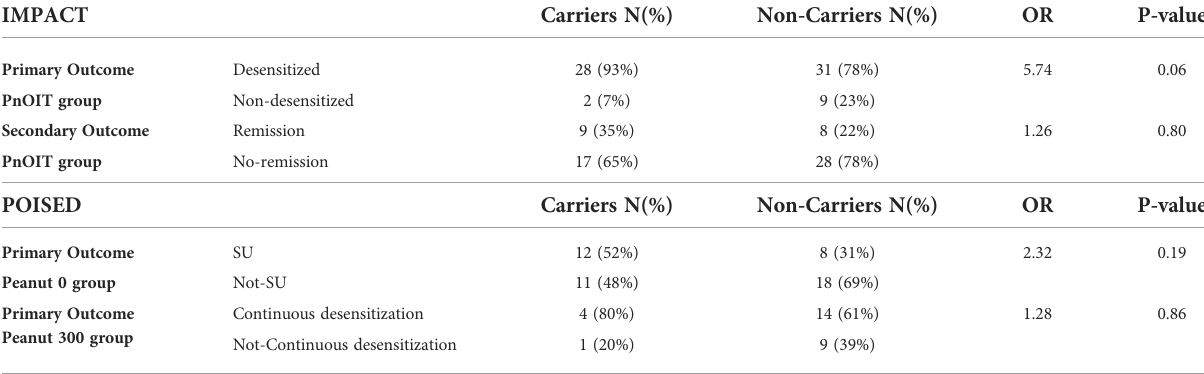
TABLE 3 Association between HLA-DQA1*01:02 and primary and secondary outcomes in IMPACT and POISED. Table shows the percentage of carriers and non-carriers with each outcome, the odds ratio (OR) and p-value.